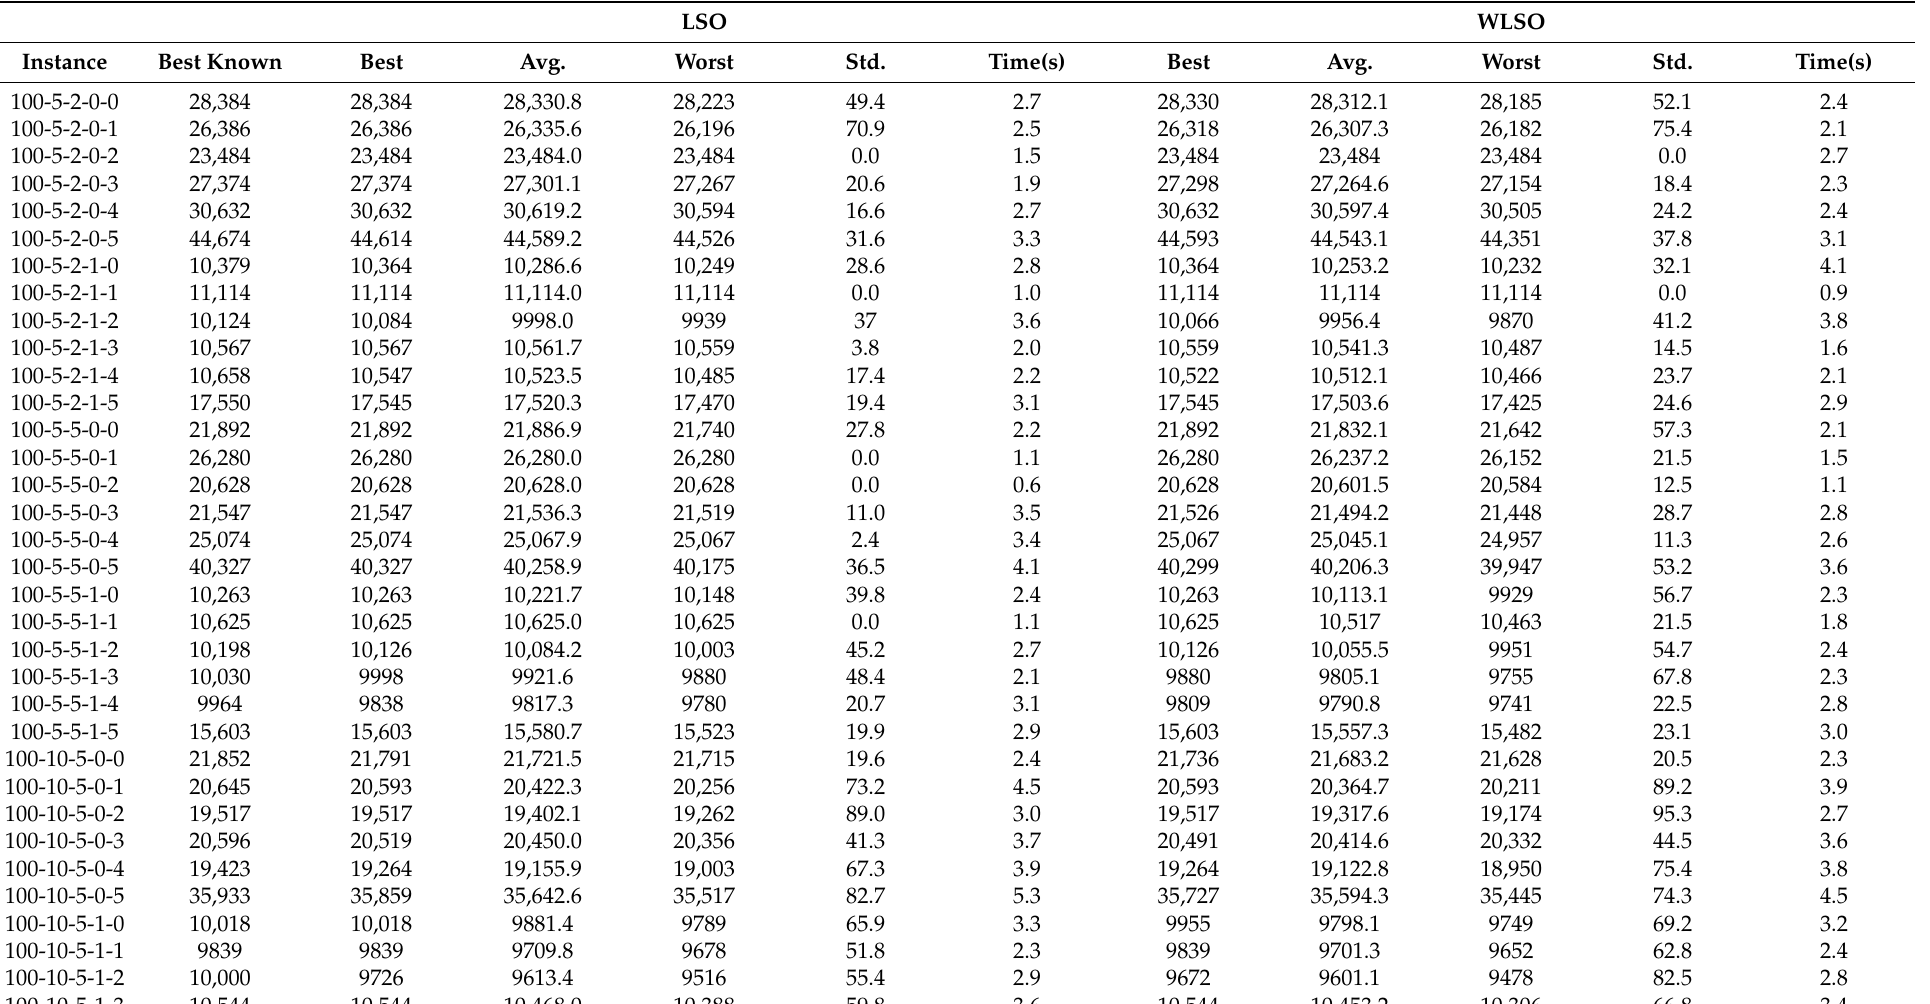
Table 2. Comparison between with and without a local search operator for the sine-cosine algorithm. LSO